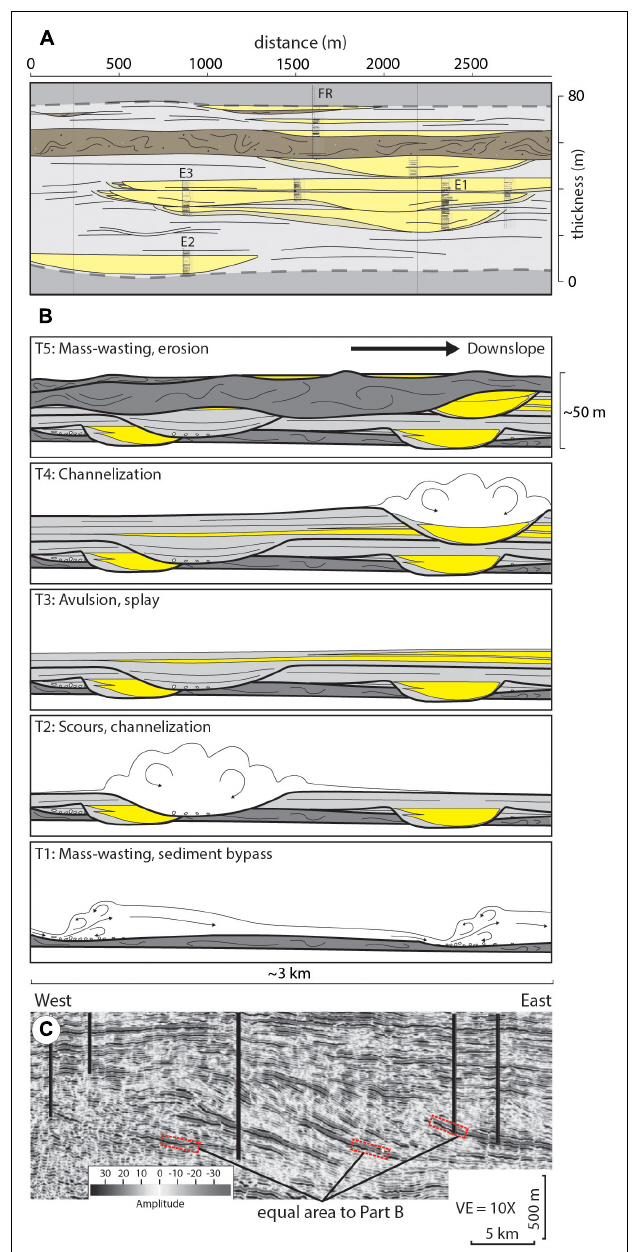
FIGURE 14 | (A) Dip-oriented schematic cross-section of channelized strata that compose a segment of the basal Figueroa clinothem package (see Figure 6A for outcrop overview). A similarly scaled perspective to this section is presented at various locations in (C) (red outlined boxes). (B) Schematic evolution of the sandstone-prone basal clinoform package in (A) . The area featured is comparable in scale and character to that featured in (A) . A sustained period of elevated off-shelf coarse-grained sediment transfer results in a composite sedimentary package defined by deposits that record erosion, mass-wasting, sediment bypass and deposition. (C) Vertical seismic section from the Magallanes Basin highlighting prograding clinothems up to 600–800 m thick, providing context for the basal clinothem segment featured in (A) (modified from Gallardo, 2014). The Late Eocene-Early Miocene strata record the infilling of the deep-water basin approximately 150 km south of the Cerro Cazador study area along the foreland basin axis.